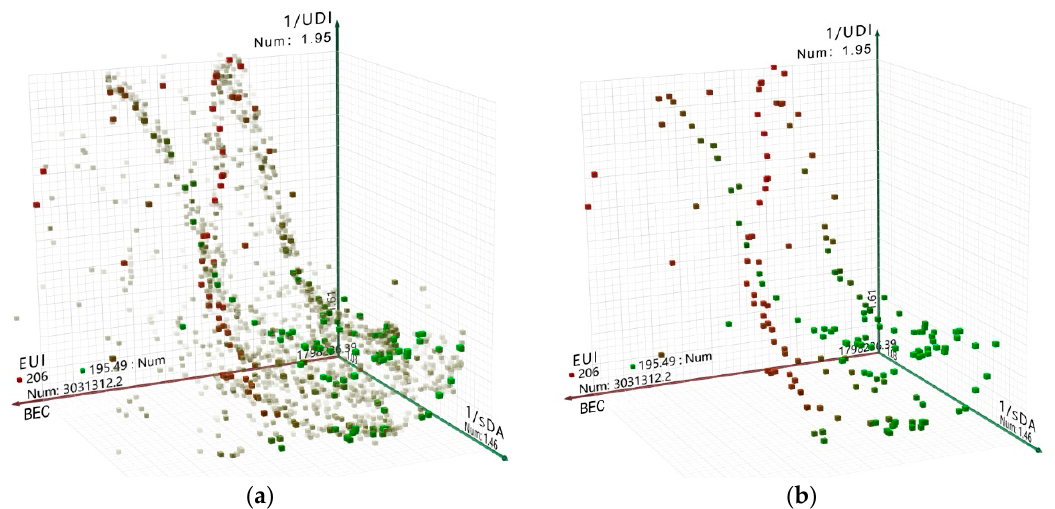
Figure 12. Many-objective optimization results: ( a ) solutions converging by generation and ( b ) non-dominated solutions of the last generation.